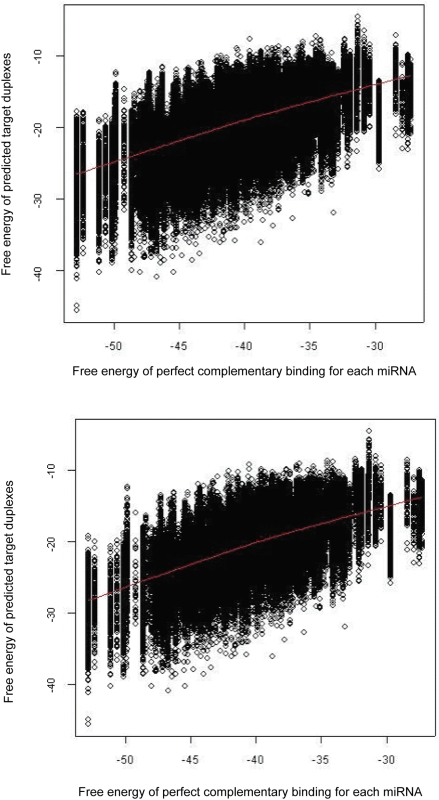
Calculated free energy of duplex formation at the miRNA target sites predicted by our approach, versus the minimum possible free energy for that miRNA binding with perfect WC base-pair complementarity to a (theoretical) target site.Free energy scores of predicted target sites (y-axis) are plotted against the free energy score of each miRNA, where each of 313 human miRNAs binds to a target site with perfect WC base pair complementary, imposing the requirement(s) of (A) WC base pairs within nucleotide positions 2–8; and (B) WC base pairs within positions 2–8, plus <6 mismatches-and-GU pairs at position 15 and beyond (see text for details). The red line is the non-parametric local fitted line.